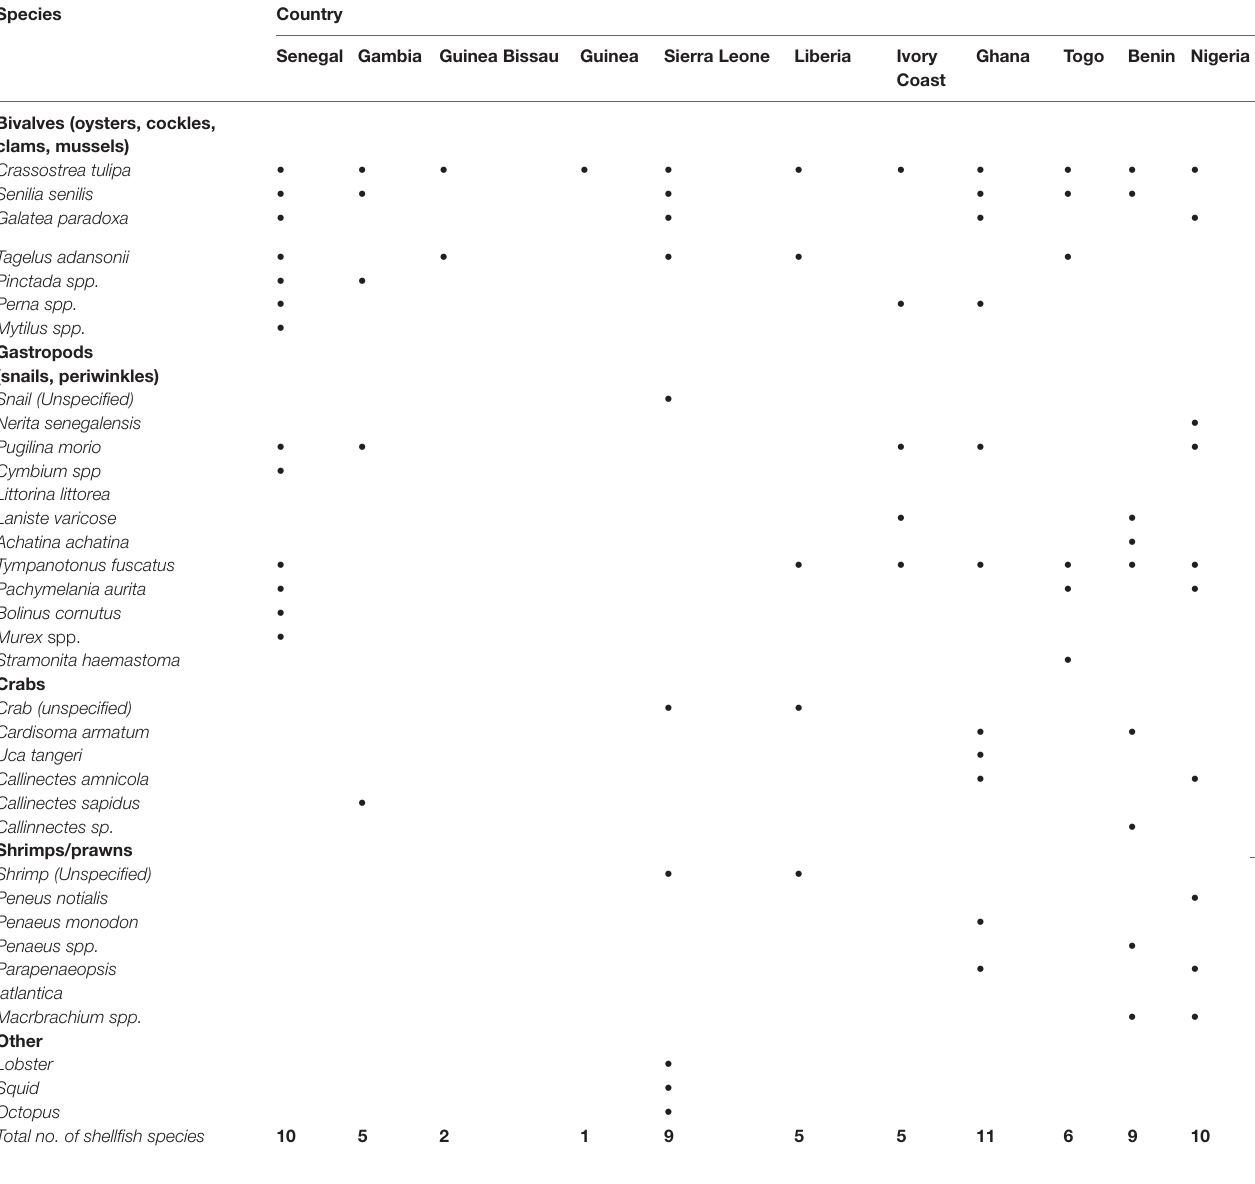
TABLE 2 | Shellfish species harvested in the estuarine and mangrove ecosystems along the coast of West Africa from Senegal to Nigeria.